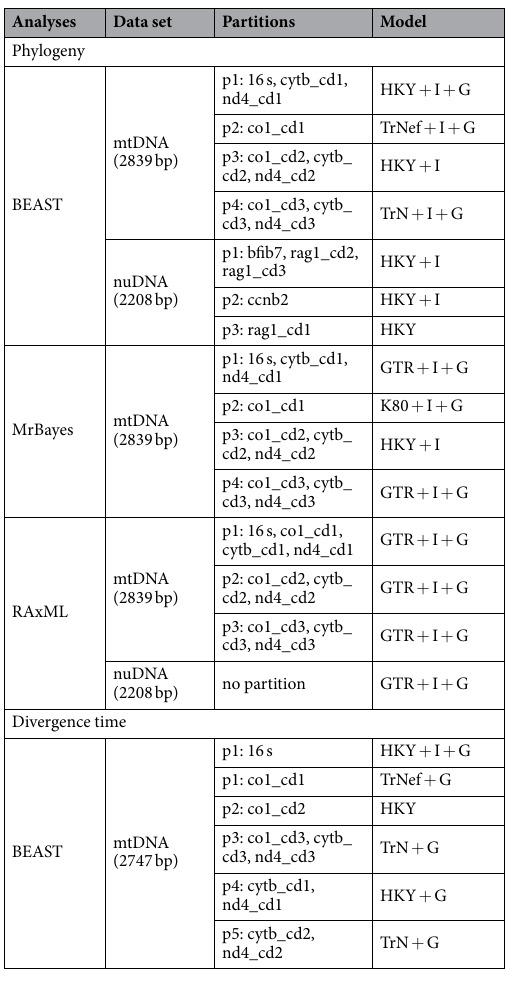
Table 1. Partition schemes and substitution models used for the divergence time